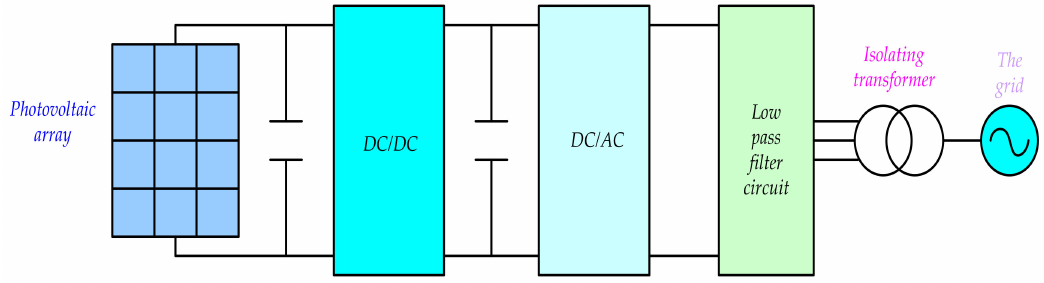
Figure 1. Topology diagram of two-stage grid-connected photovoltaic power generation